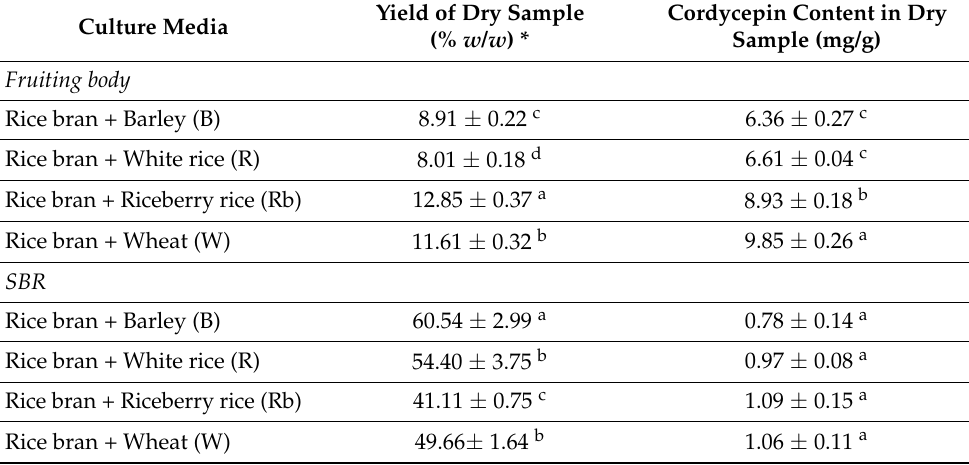
Figure 1. Morphology of C. militaris cultivated on solid media containing defatted rice bran and different types of cereals, and the appearance of dry solid-based residues (SBRs) prepared from different culture media: ( a , e ) barley, ( b , f ) white rice, ( c , g ) Riceberry rice, and ( d , h ) wheat. Table 1. Yields of fruiting bodies and solid-based residues (SBRs), and cordycepin content obtained from the cultivation of C. militaris with different culture